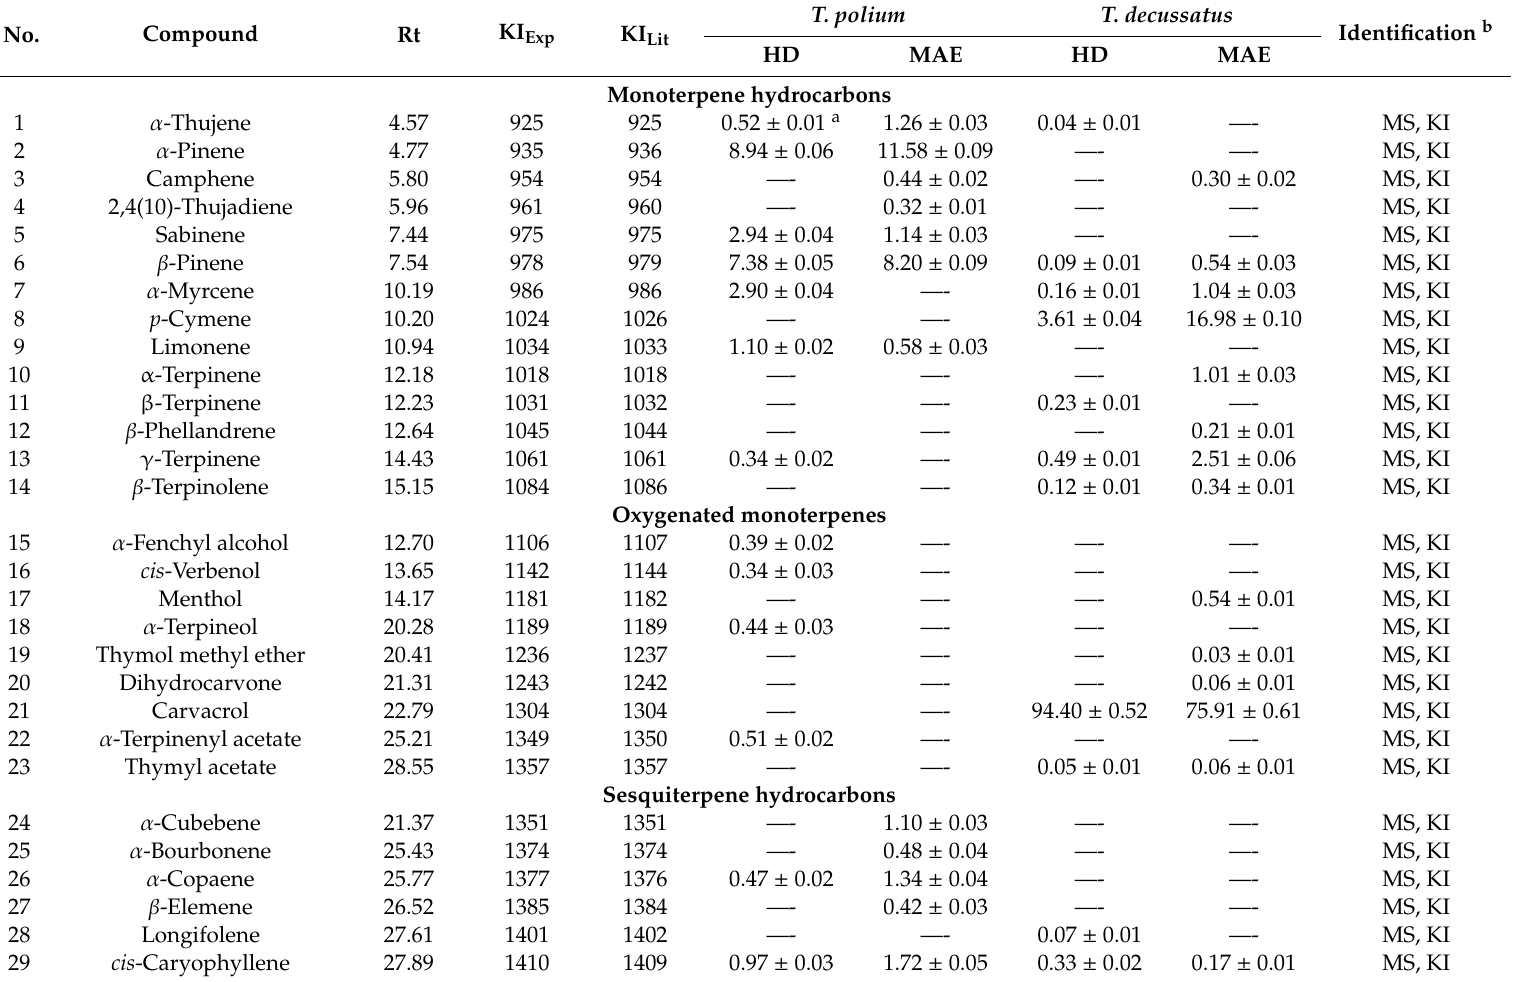
Table 1. Chemical profiles of Essential oils (EOs)of Teucrium polium and Thymus decussatus extracted using hydrodistillation (HD) and microwave-assisted extraction (MAE)